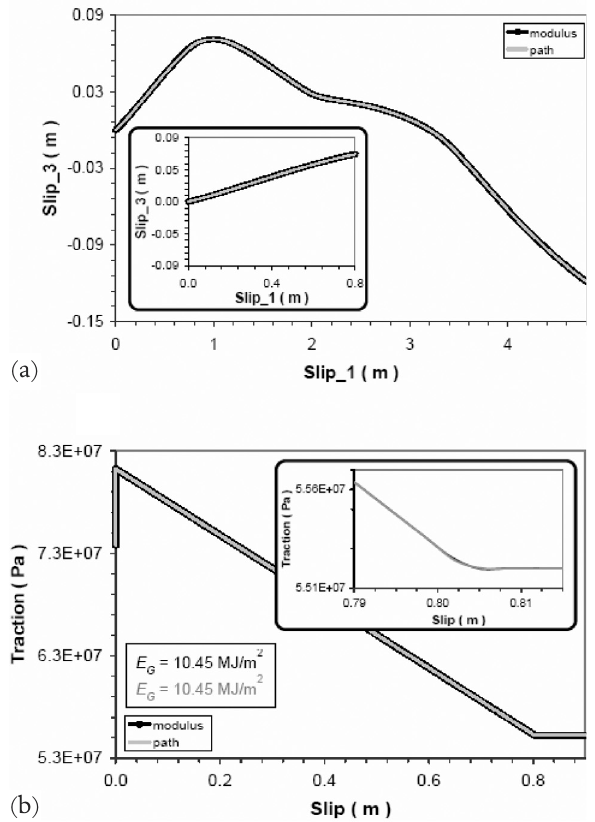
versus u ) in Figure 3. (a) Fault striation (i.e., time evolution of u 3 1 the fault node (4.3, 3.125) km. In the inset panel we report a zoom (once the slip ex- of values up to the characteristic SW distance d 0 ceeds the formulations (1) and (2) are identical, since the magnitude of the shear traction x does not depend on the slip anymore). (b) Traction versus slip curve, in the same fault node as in panel (a), = d . Values of the frac- with inset panel reporting a zoom up to u 1 0 ture energy density E are also indicated for the two numerical sim- G ulations ( E is computed from Equation (18) of Bizzarri [2011]). In G all panels, thick black lines refer to the formulation (1), slip modu- lus, while thin gray lines refer to the formulation (2), slip